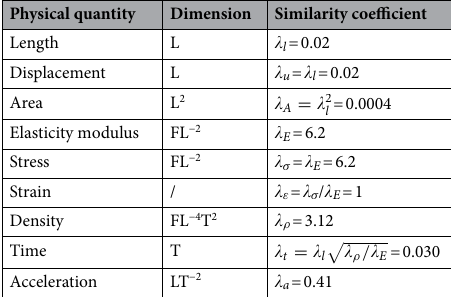
Table 2. Similarity coefficients for the test